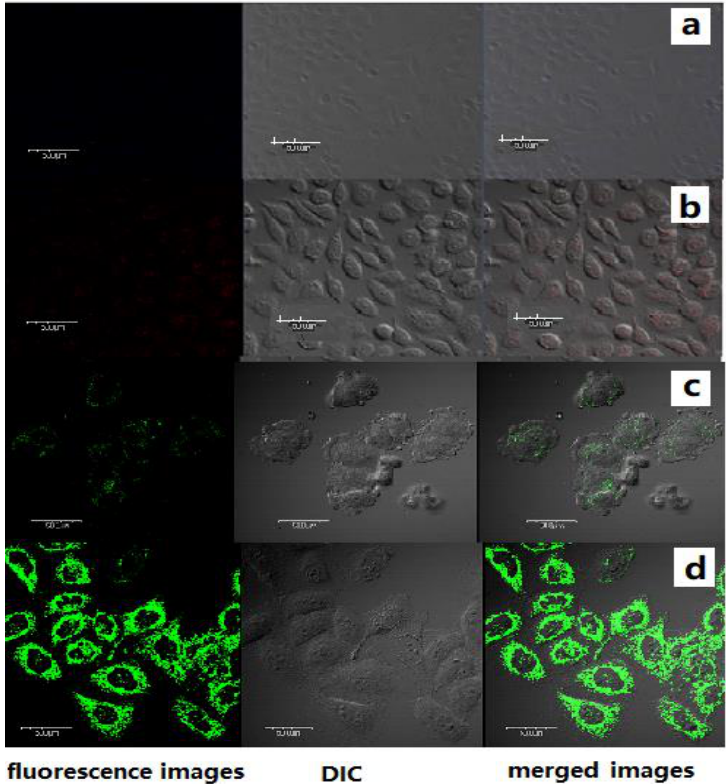
Figure 5. TP fluorescence ( left ), DIC (Di ff erential interference contrast, middle), and merged ( right ) images of SiHa cells were incubated for 1 h at 37 ◦ C with di ff erent systems including ( a ) BAPTAVP (5 µ mol / L); ( b ) BAPTAVP (5 µ mol / L)-Ca 2 + (5 µ mol / L); ( c ) PCBMB(5 µ mol / L)-BAPTAVP(5 µ mol / L); and ( d ) PCBMB (5 µ mol / L)-BAPTAVP (5 µ mol / L)-Ca 2 + (5 µ mol / L). The excited wavelength was 800 nm. The scale bar in a-d is all of 500 μm.